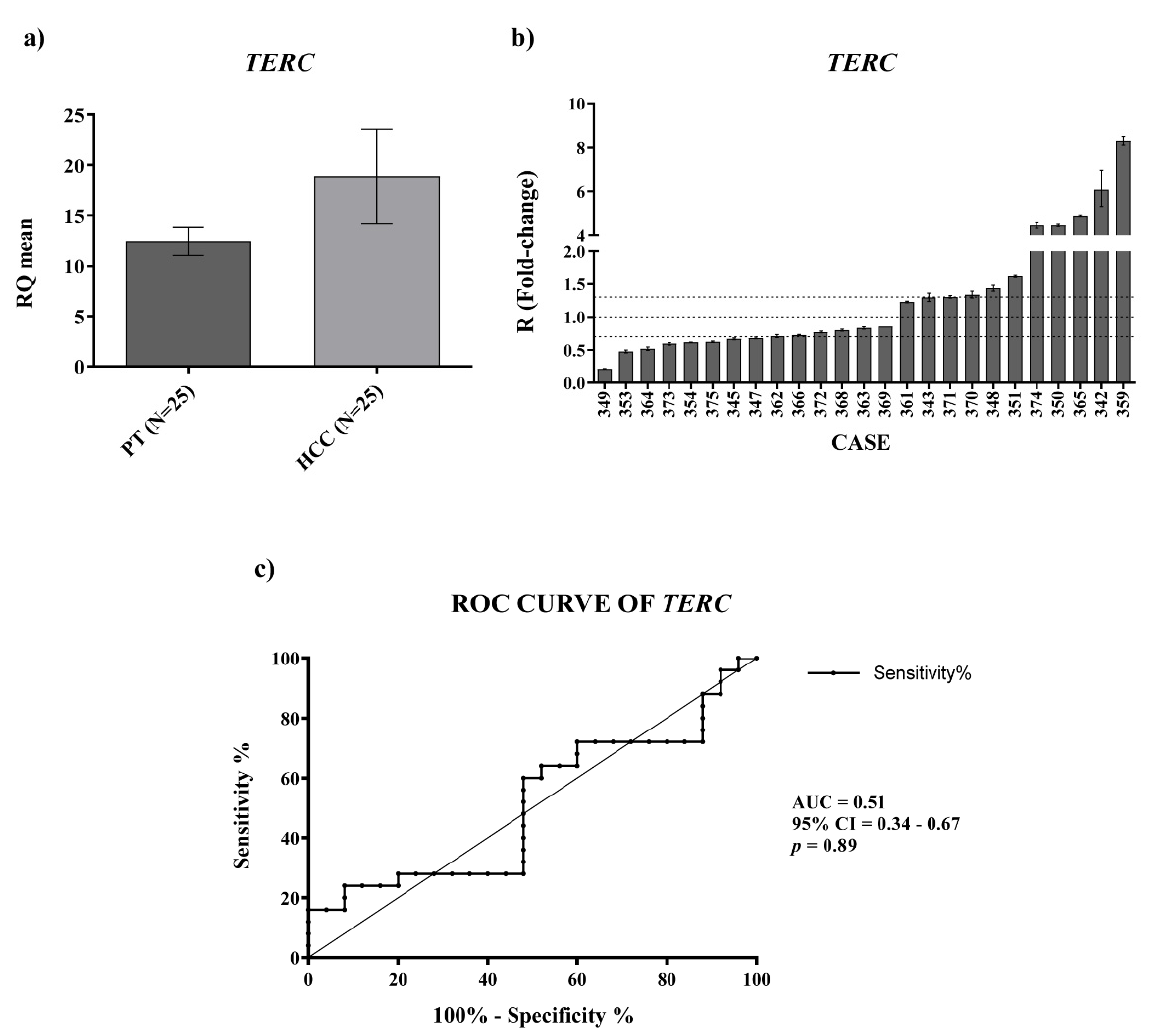
Figure 2. Tissue expression of TERC . ( a ) TERC relative quantification mean comparison between PT and HCC. Wilcoxon test was used. ( b ) TERC fold-change. Histograms represent R-values and bars upper and lower limits. Histograms are ordered by increasing R-values. The corresponding cases are listed on x axis. Upper and lower dot lines define the range of gene expression variation. ( c ) ROC curve analysis of TERC to discriminate HCC from normal tissue. AUC: area under the ROC curve’ CI: confidence interval.